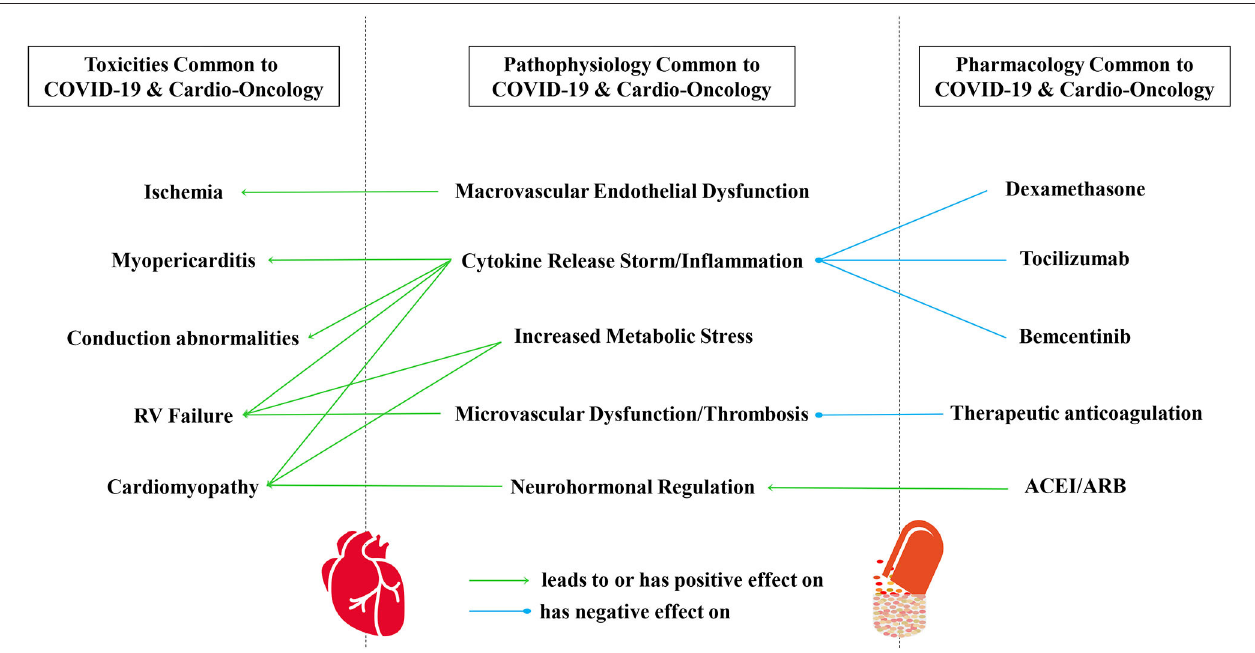
FIGURE 1 | A conceptual framework of commonalities in CV toxicities, pathophysiology, and pharmacology common to COVID-19 and cardio-oncology. CV toxicities common to COVID-19 and cardio-oncology include myocardial injury, cardiomyopathy, myopericarditis, ischemia, conduction abnormalities, and RV failure, in part mediated by immune system activation, cytokine release syndrome, and arterial and venous coagulopathy. All of these are also examples of oncologic CV toxicities that can result from pharmacologic or radiation therapies. Indeed, the pathophysiology and modulation of SARS-CoV-2 infection remains under investigation, with components of viral infection/invasion, macrovascular endothelial dysfunction, cytokine release syndrome/inflammation, microvascular dysfunction/thrombosis, neurohormonal regulation, coagulopathy, and increased metabolic stress. Several pharmacologic considerations have risen to the surface during the pandemic, involving steroids, cancer immunotherapy, biologic antibodies and inhibitors, drug repurposing, the role of cyp450 and drug transporters in drug-drug interactions, anticoagulation, and neurohormonal regulation. ARB, Angiotensin Receptor Blocker; ACEI, Angiotensin Converting Enzyme Inhibitor; CV, Cardiovascular; COVID-19, Coronavirus Disease of 2019; RV, Right Ventricle; SARS-CoV-2, Severe Acute Respiratory Syndrome